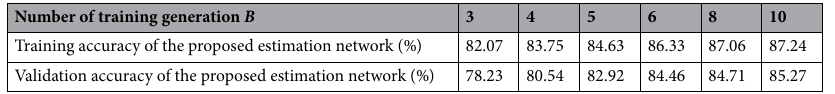
Table 2. Micro-F1 accuracy versus different number of training generation B .